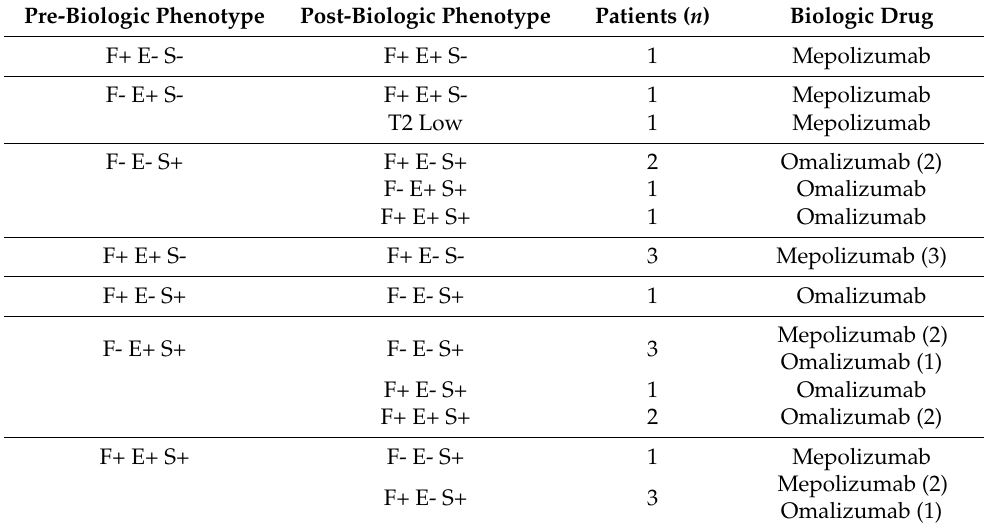
Table 2. Changes in T2 biomarkers positivity in 21 T2-high severe asthma patients treated with biologics.